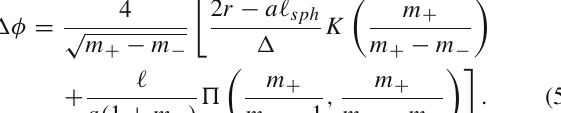
Fig. 5 The graphs of the characteristic functions m θ ( r ; a ) (full black curve), m φ ( r ; a ) (dashed black curve) and m z E ( r ; a ) (grey curve) are given for appropriately chosen values of the spin parameter a , demon- strating all qualitatively different cases of their behaviour. Grey ver- tical line is an asymptote of m z E ( r ; a ) . Dark shading demarcates the